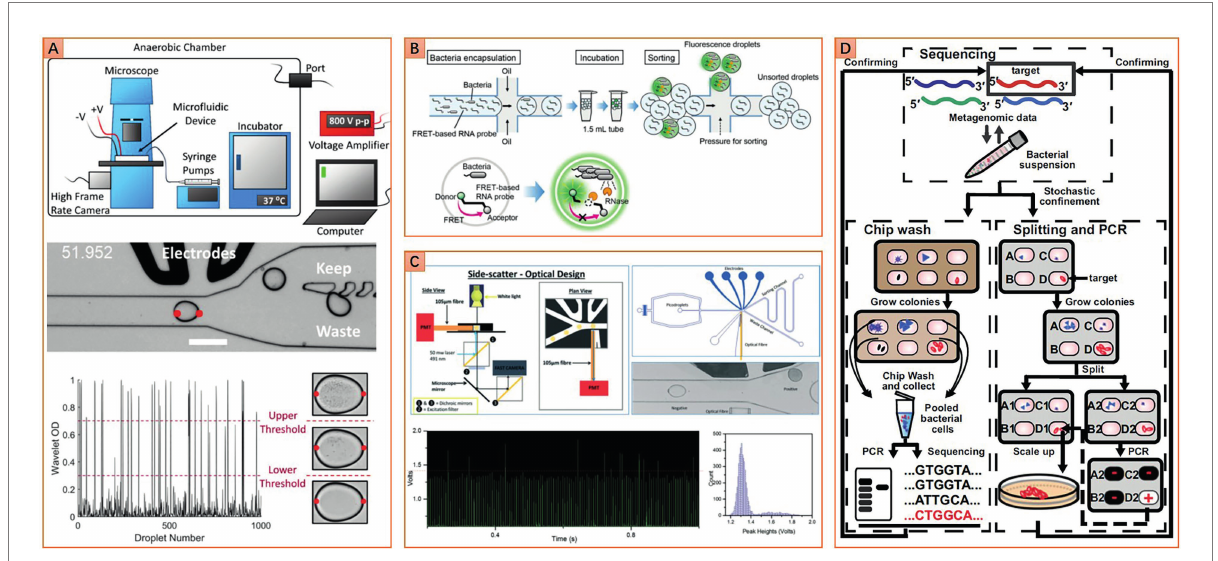
FIGURE 4 Diverse microfluidic approaches for targeted isolation of interested taxa. (A) Image-based approach, image analysis algorithm is used to distinguish droplets with different cell densities (Reprinted from Watterson et al., 2020 with the permission of eLife Sciences Publications Ltd.); (B) Fluorescence-based approach, fluorescence resonance energy transfer-based (FRET-based) RNA probe is used to detect metabolic activity in droplets, other kinds of probe like the fluorogenic substrate or resazurin and their derivatives can be set as alternatives (Reprinted from Ota et al., 2019 with the permission of PLOS publishing); (C) Turbidity-based approach, variation of droplet turbidity caused by cell proliferation is detected via scattered light signal (Reprinted from Liu et al., 2016 with the permission of Royal Society of Chemistry); (D) Gene-targeted cultivation and isolation, PCR was carried out on one replica of the SlipChip to locate the target on another replica of the SlipChip (Reprinted from Ma et al., 2014b with the permission of National Academy of